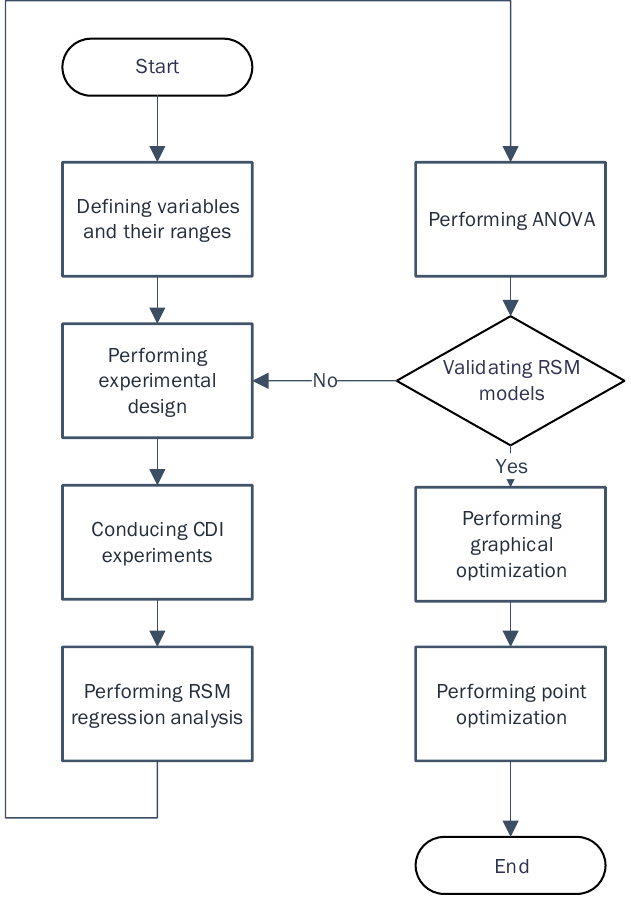
Figure 3. Flow chart for the RSM-based optimization.